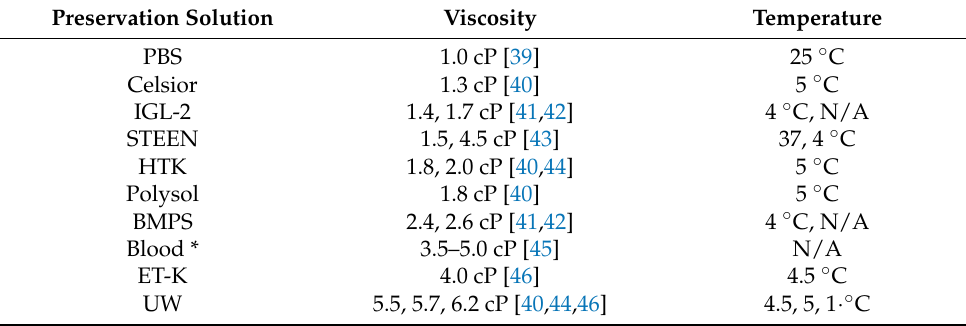
Table 1. Viscosity Range of Preservation